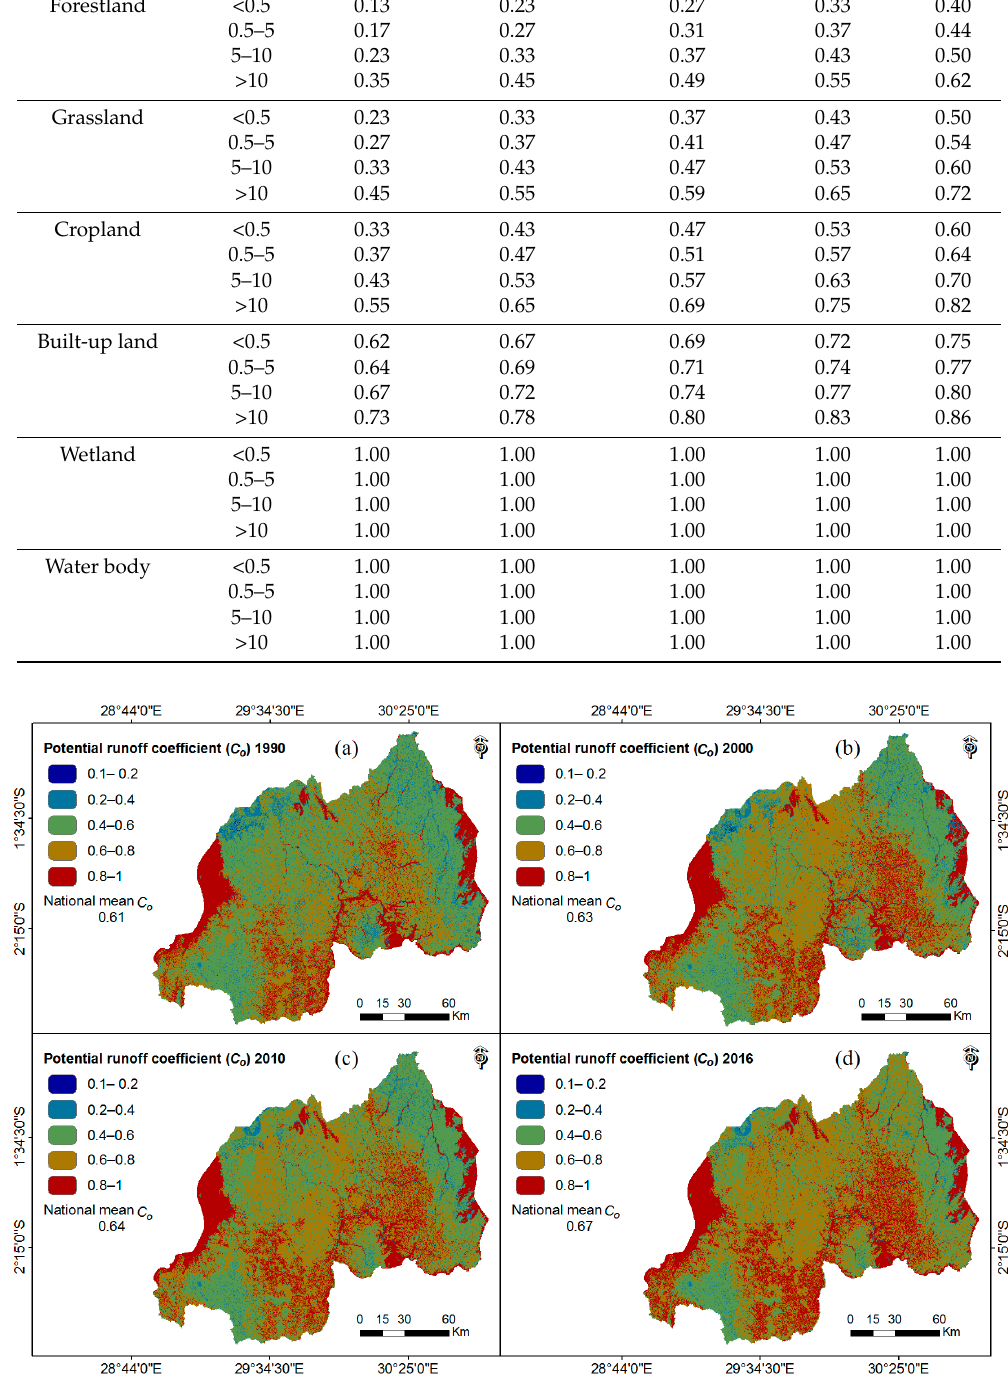
Figure 3. Maps of the potential runoff coefficients of Rwanda for the periods: ( a ) 1990; ( b ) 2000; ( c ) 2010; and ( d ) 2016.